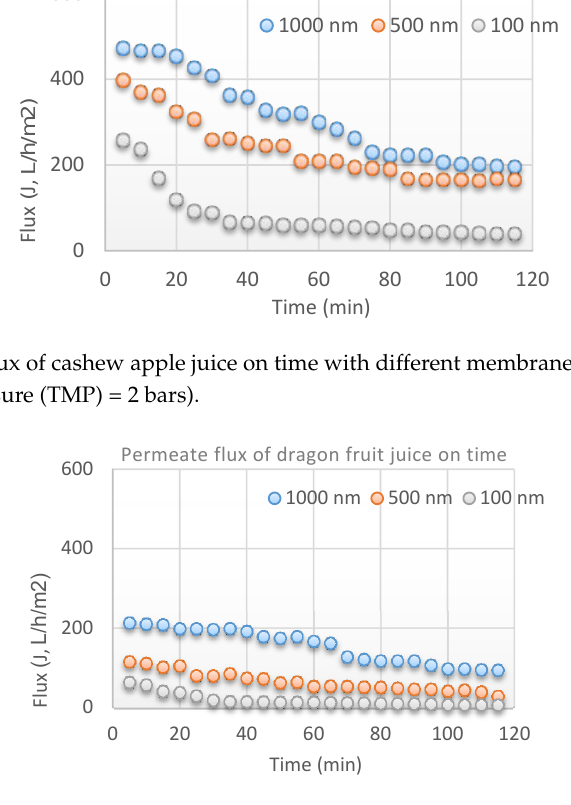
Figure 3. Permeate flux of dragon fruit juice on time with different membrane pore sizes ( T = 30 °C; TMP = 2 bars).